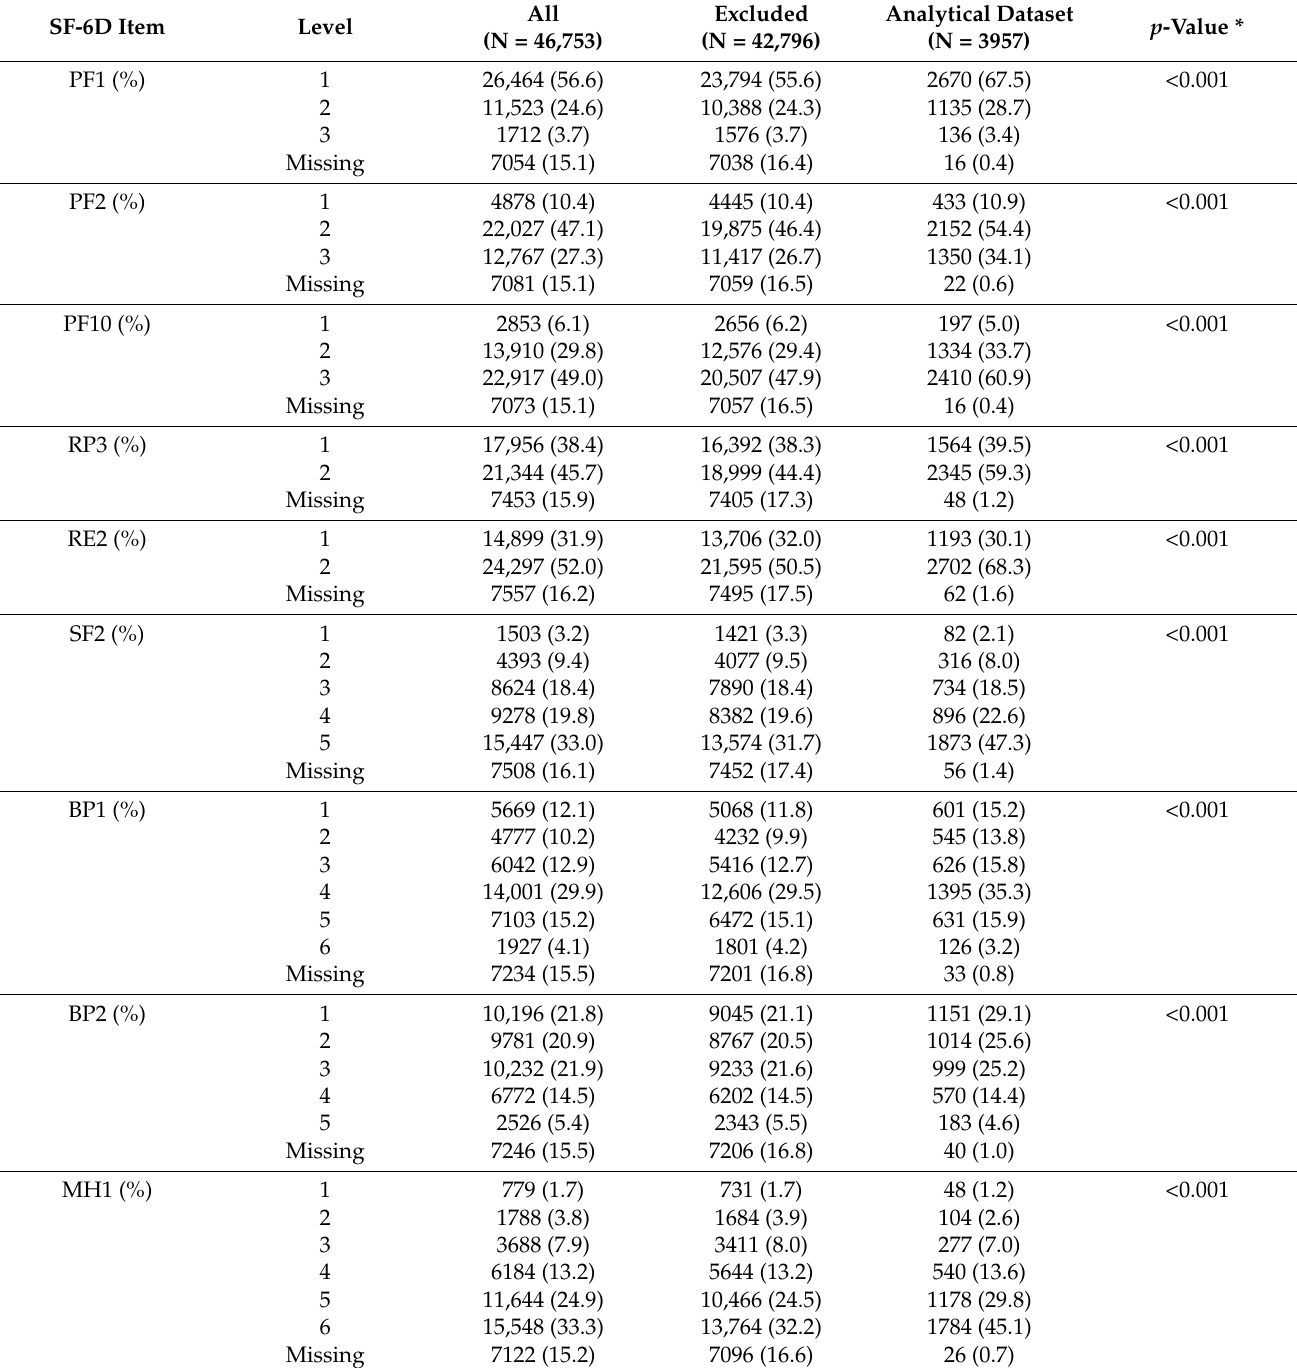
Table 2. Scores for the selected SF-36 items and SF-6D index at